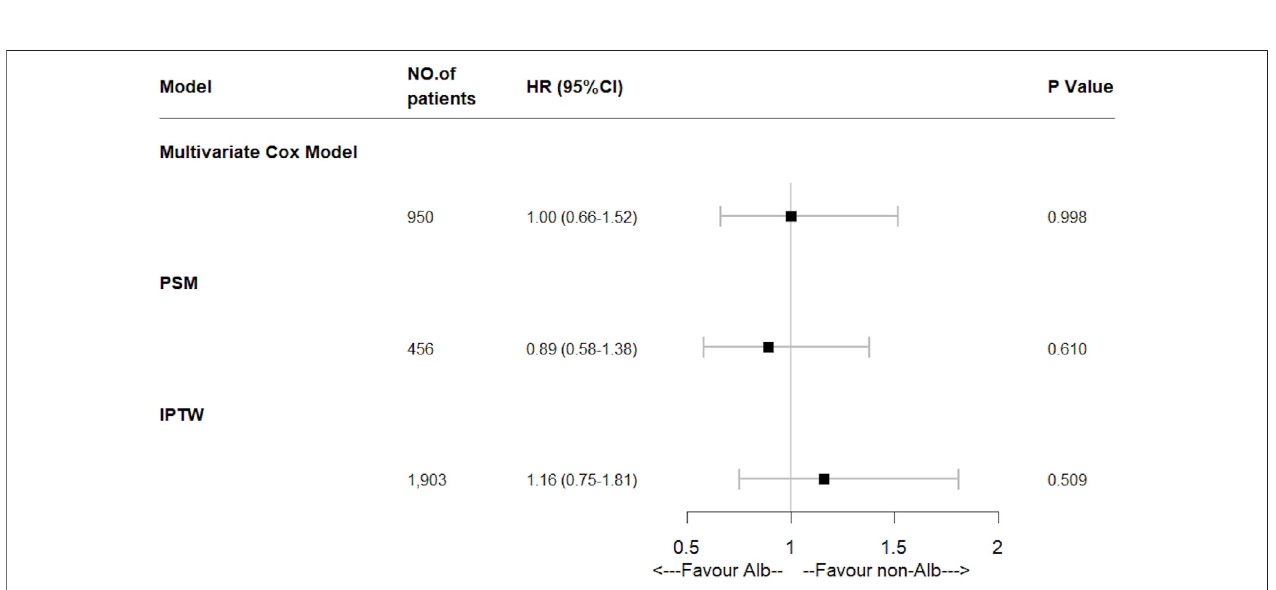
FIGURE 3 | Effect of human serum albumin infusion on primary outcome in acute pancreatitis patients from the MIMIC-IV database before and after matching through multivariate Cox regressions. HR, hazard ratio; PSM, propensity score matching; IPTW, inverse probability of treatment weighing.